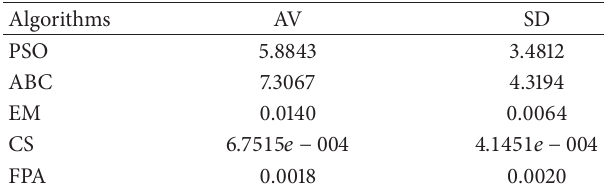
Table 4: The average 𝑓(𝜃) value (AV) and the standard deviation (SD).